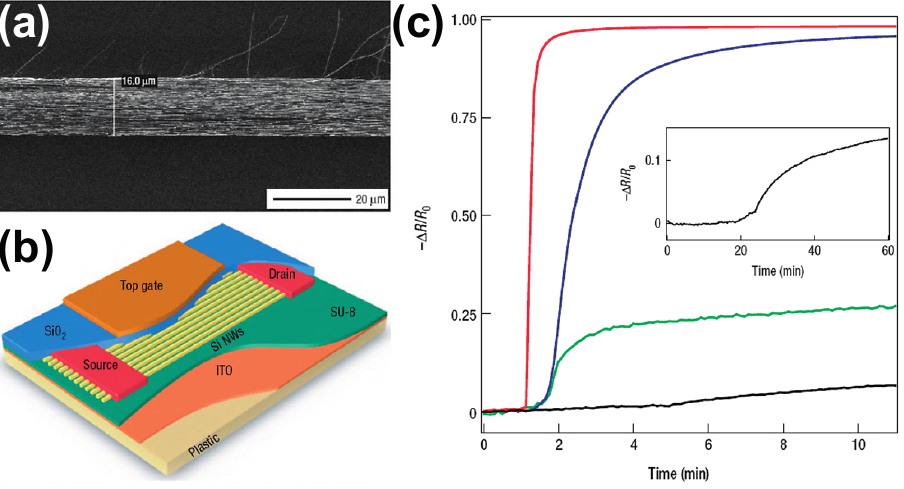
Figure 11. ( a ) SEM image of the transferred nanowires on plastic; ( b ) Schematic image of nanowire field-effect sensor on plastic; ( c ) Electrical response of a nanowire array sensor to 20 ppm (red curve), 2 ppm (blue curve), 200 ppb (green curve) and 20 ppb (black curve) diluted in N . Inset: an extended response of the sensor to 20 ppb NO NO 2 2